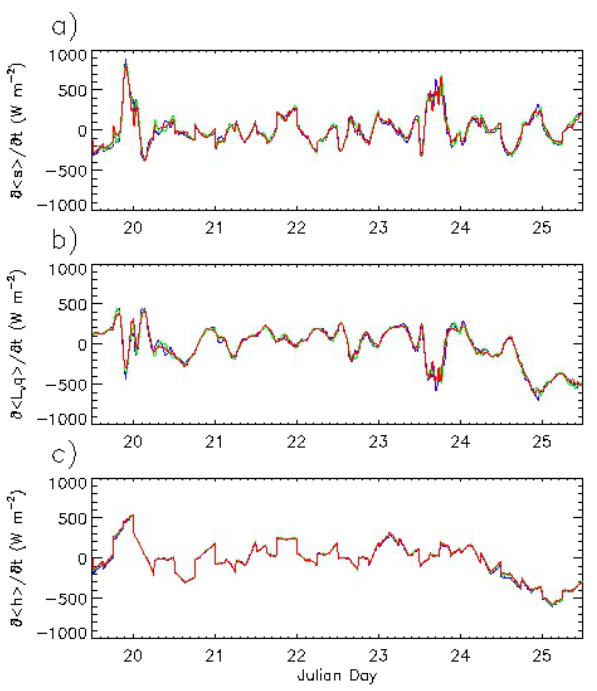
Fig. 10. Timeseries of ensemble- and horizontally-averaged and vertically-integrated time tendencies: (a) ∂ ∂ h h i for PRIS (blue), POLL (green), and SPOLL (red). ∂t